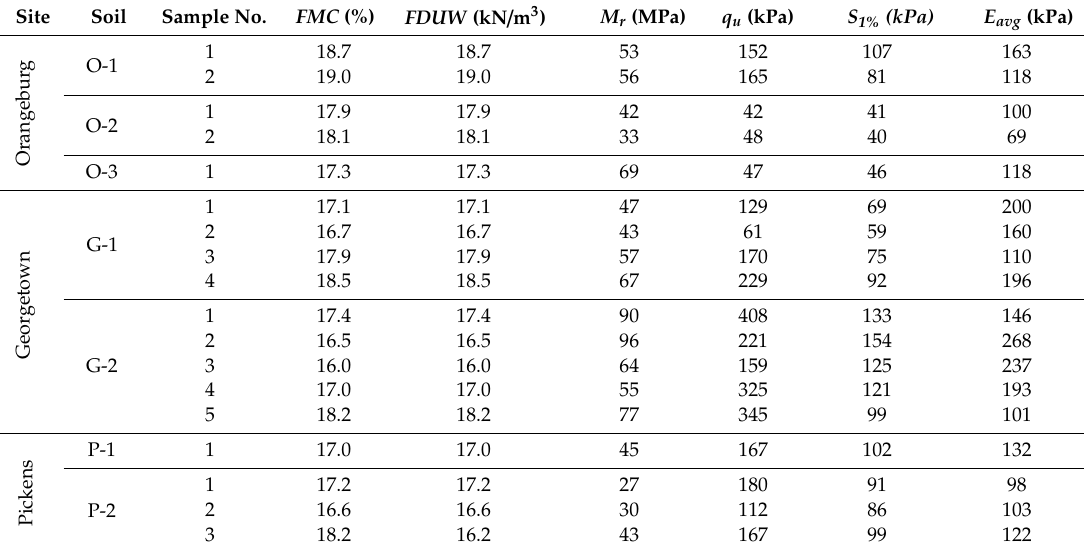
Table 4. Summary of results for tests performed on Shelby tube